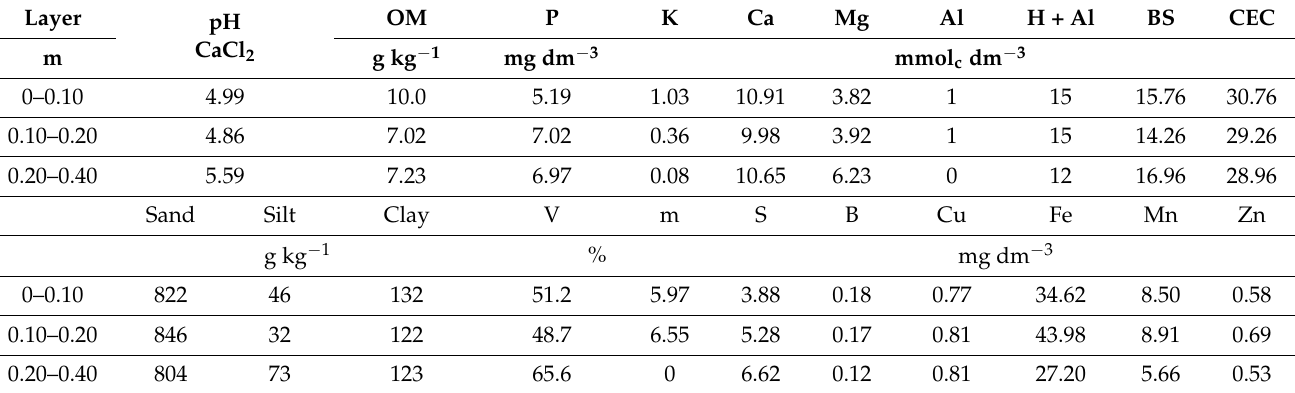
Table 1. Soil physical and chemical properties at the beginning of the study in